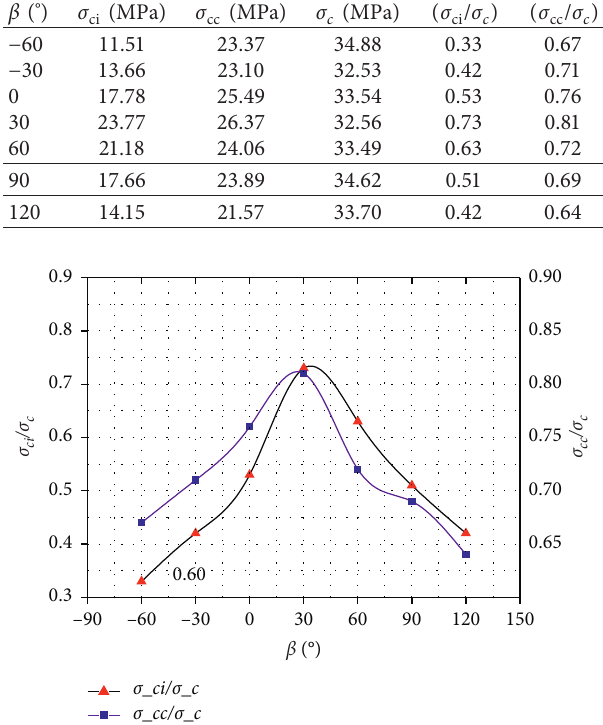
Figure 13: The dip of the rock bridge with main flaw ( β ) versus the crack initiation and coalescence stresses ( ( σ